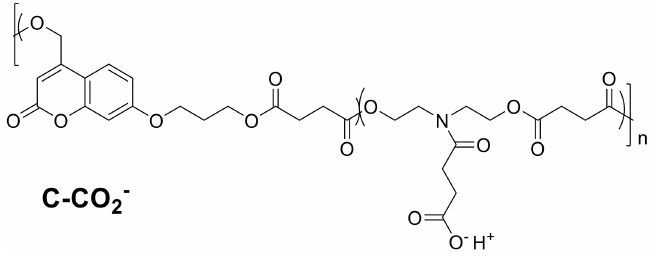
Figure 24. Structure of the synthesized anionic coumarin polyester.